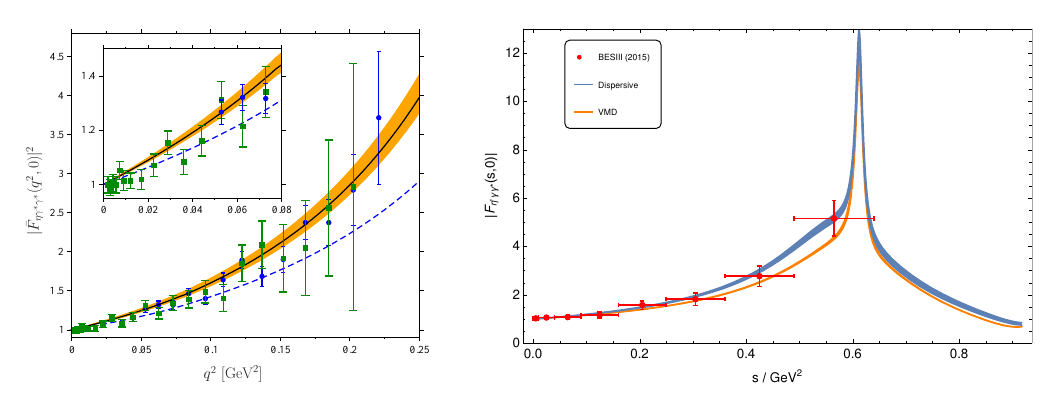
¯ F 2 , 0) 2 to data from the A2 [16] ηγ ∗ γ ∗ ( q | |